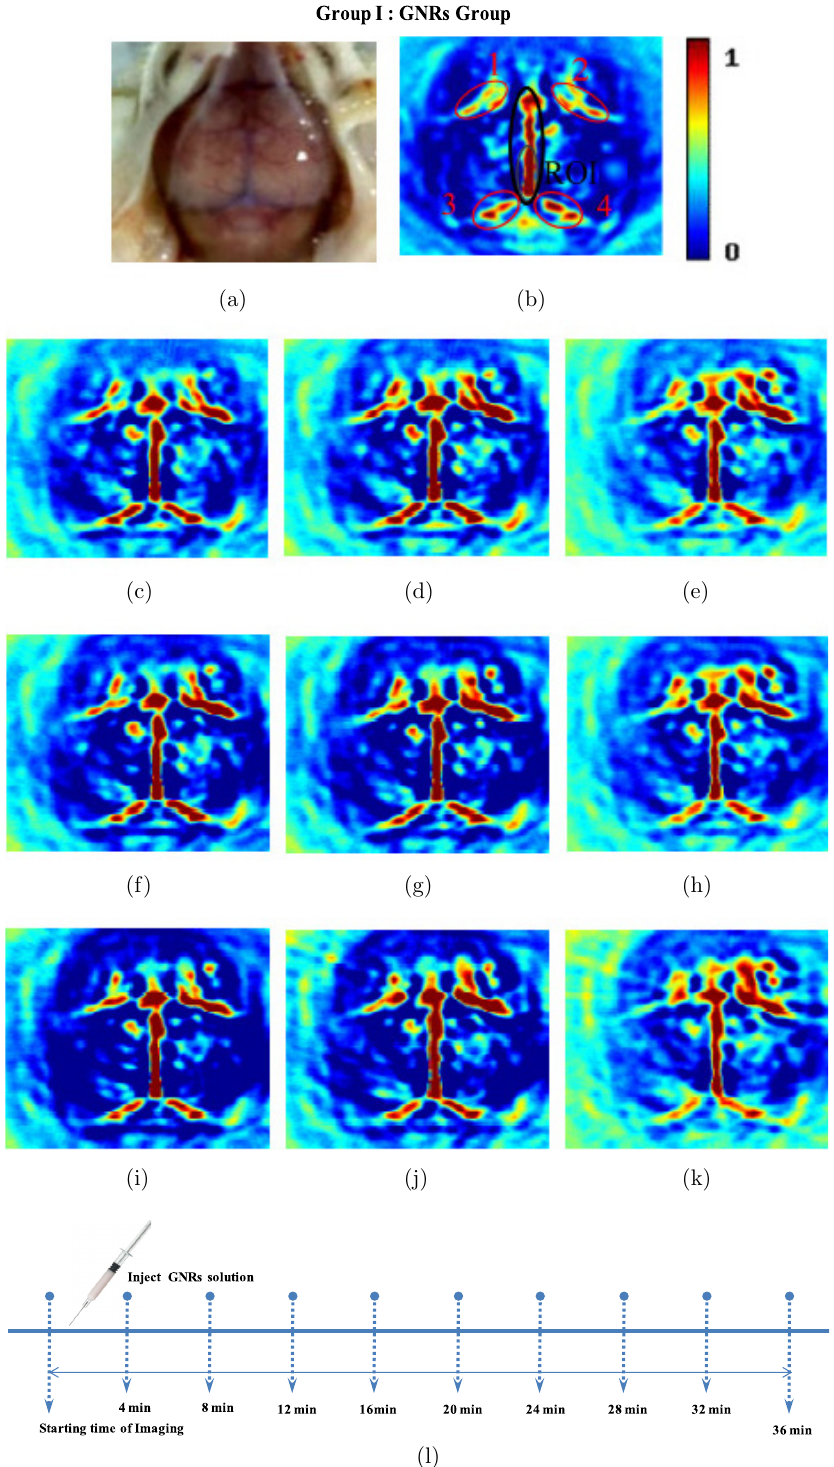
Fig. 3. (a) Open-skull photograph of a mouse brain surface after the imaging experiments. (b) – (k) 10 in vivo PAT brain recon- structed images of the cerebral vasculature of a mouse brain prior to GNRs injection (b), 4 min – 36 min post injection (c) – (k) in Group I. (l) Experimental timeline for Group